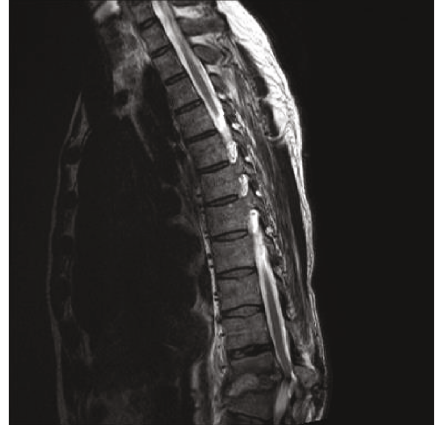
Figure 3: MR thoracic spine T2-weighted image 1 month later showing progressive collapse of T11 and T12 vertebral bodies and severe spinal